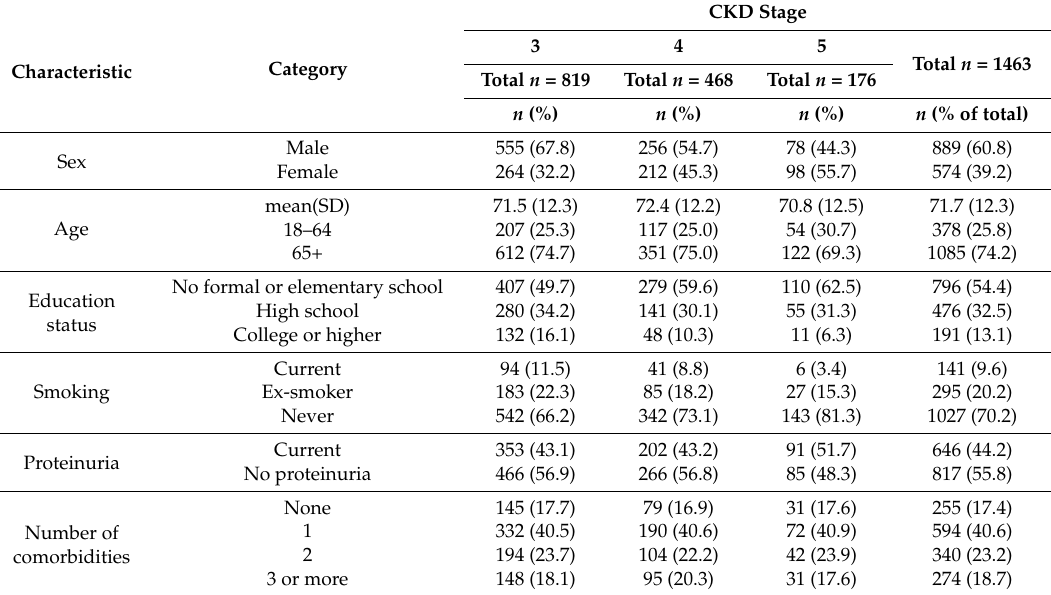
Table 1. Demographic and clinical characteristics of the patients at referral.